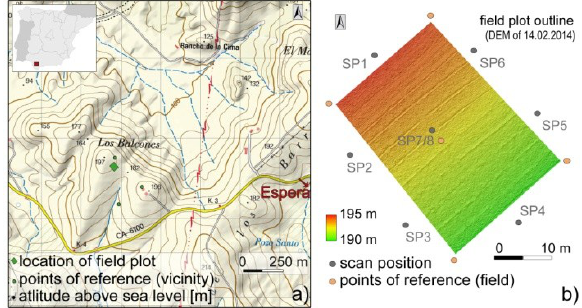
Figure 1. Description of the study site. a) Location of the field plot and setup of multi-temporal reference points (map from IGN Spain, http://www2.ign.es/iberpix/visoriberpix/visorign.html), b) Positions of scanning device during each field campaign and setup of further field proximal reference points.